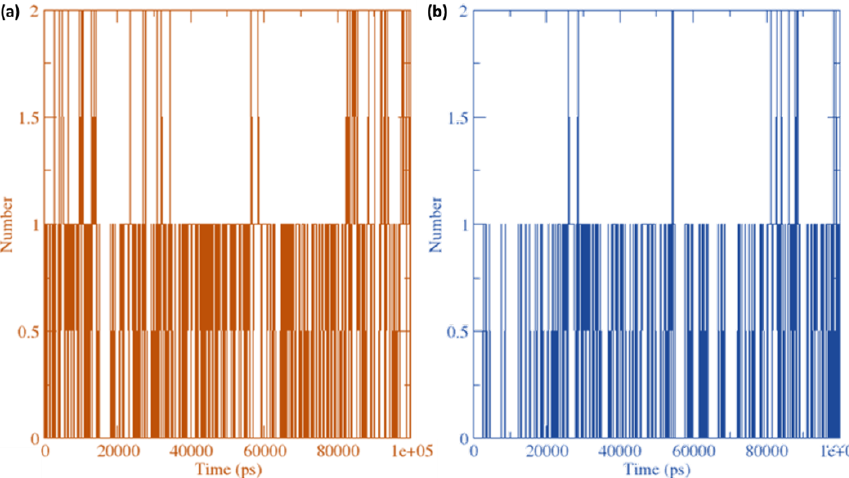
Figure 14. Average hydrogen bonding interactions between ( a ) [(FXN)(PA)] – serotonin and ( b ) (FXN) – serotonin at 100 ns simulation.